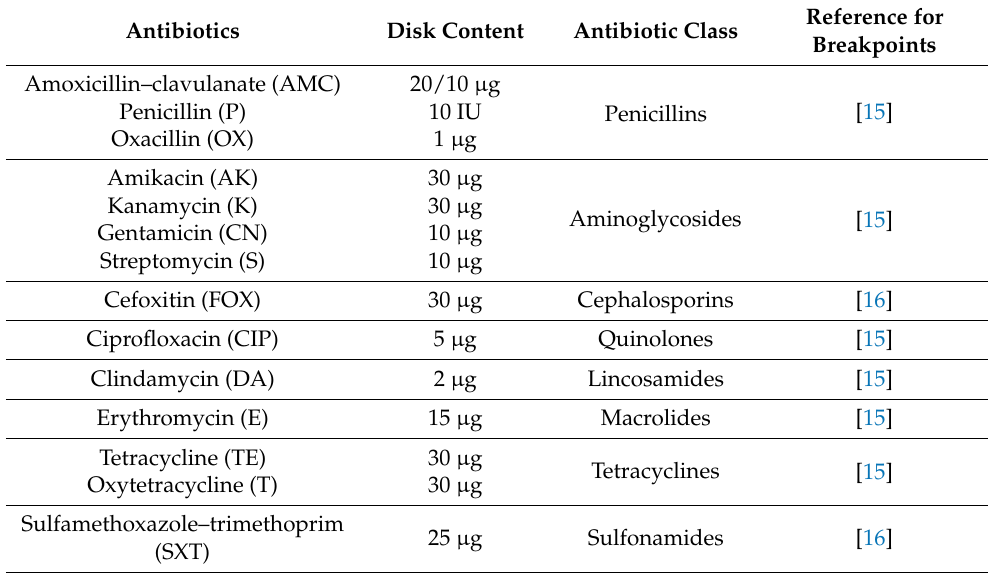
Table 2. Antibiotic classes tested to define the antimicrobial susceptibility profiles of the isolates. Antibiotics Disk